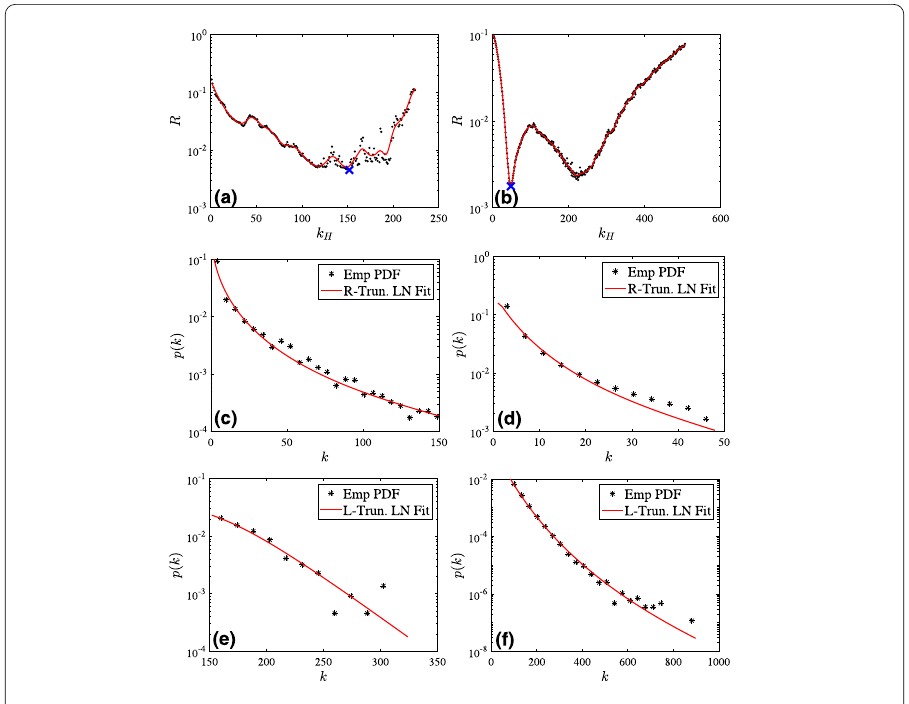
Figure 2 Results of the optimal truncated distribution of degrees for SVEIN ( a ), ( c ), ( e ) and SVCN ( b ), ( d ), ( f ). ( a ), ( b ) Plots of the fitting residual (Eq. (7)) as a function of threshold k H . ( c ), ( d ) Plots of the right-truncated degree distributions. ( e ), ( f ) Plots of the left-truncated degree